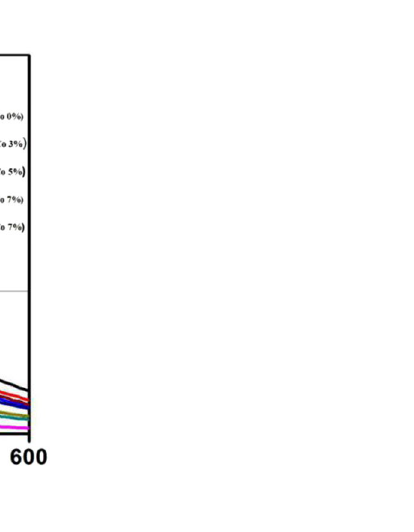
Figure 6. Fluorescence spectra of the g-C 3 N 4 /Ni x Co 1 − x S 2